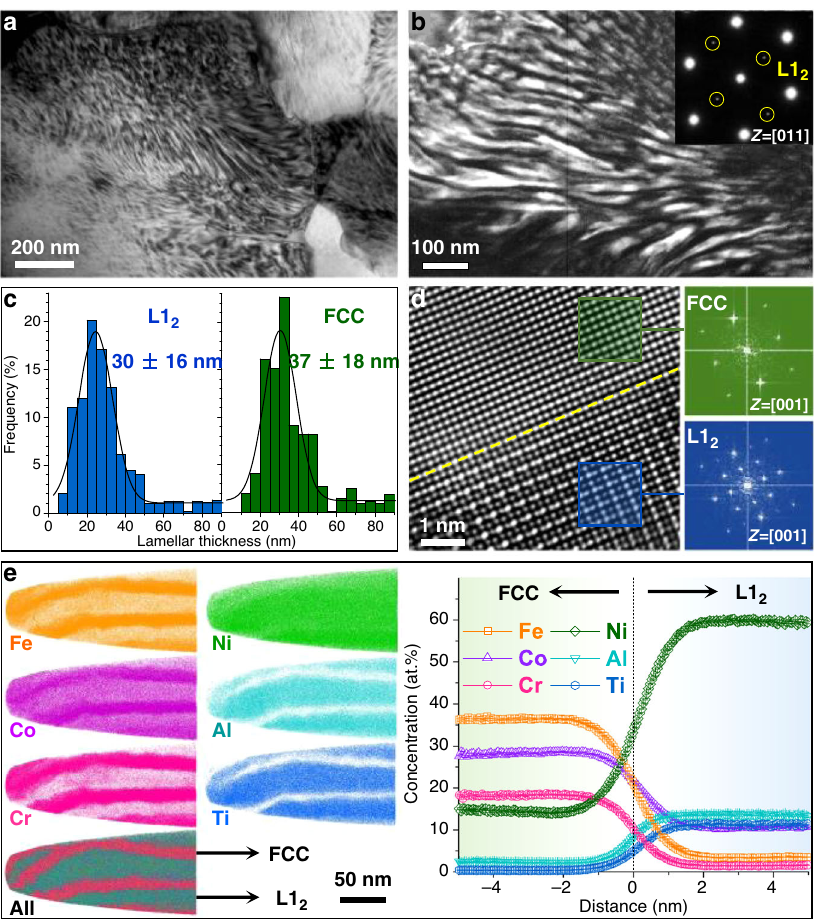
Fig. 2 Unique nanolamellar architecture of the CNL alloy. a , b Bright- fi eld and dark- fi eld TEM microstructure of the FCC and L1 2 nano-lamellae within ultra fi ne grains. c Statistical distributions for thicknesses of the FCC and L1 2 nano-lamellae. d High-resolution TEM image illustrating the interfacial coherency of the FCC/L1 2 lamellar boundary. e APT characterization of the elemental partitioning and composition of the FCC and L1 2